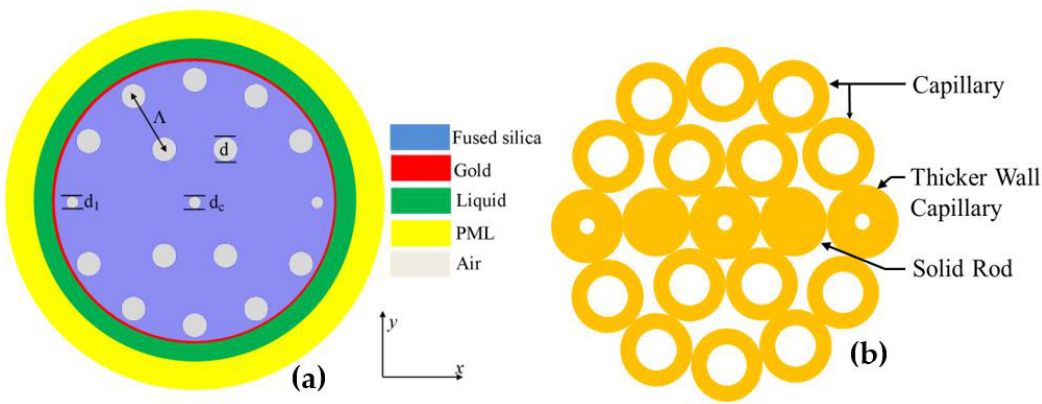
Figure 1. ( a ) Cross-sectional view of the proposed circular lattice PCF sensor with Λ = 2 μm, d c = d 1 = 0.2Λ, d = 0.4Λ, and t g = 40 nm. ( b ) Stacked preform of the proposed PCF.